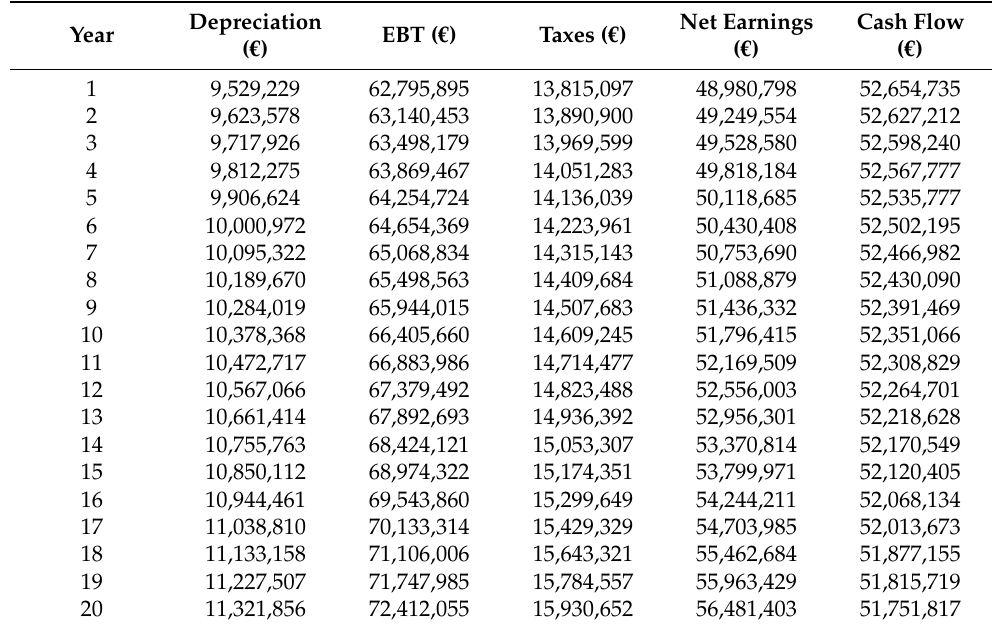
Table 1. Results of economic assessment.